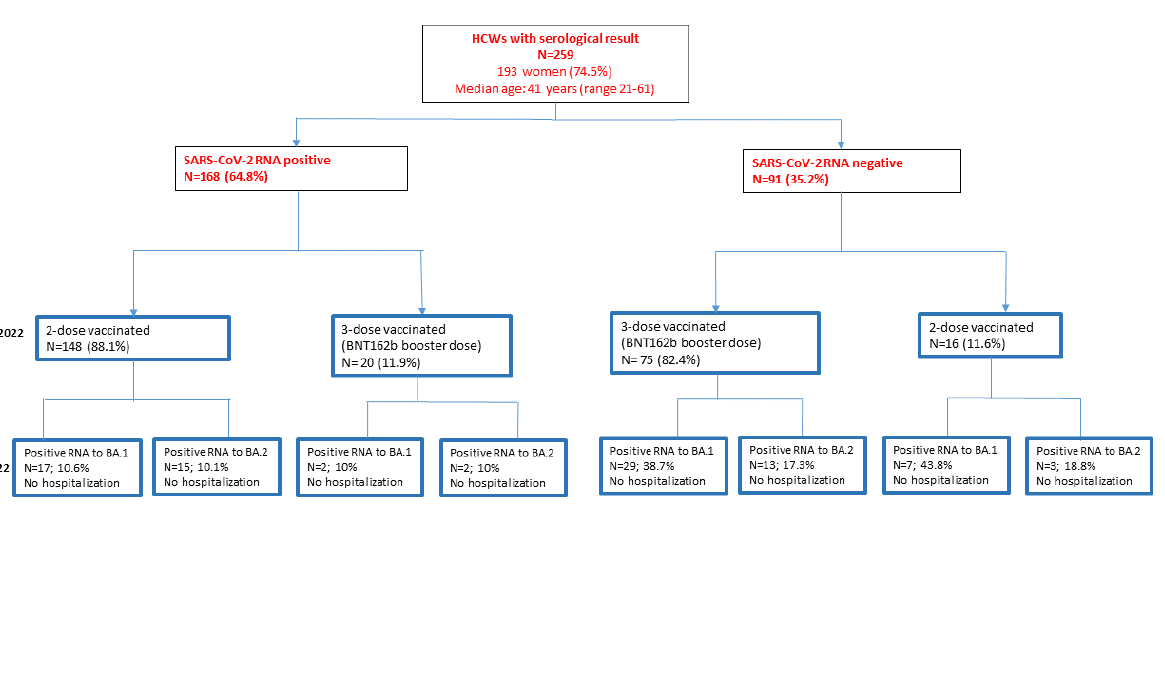
Figure 1. Study flowchart.